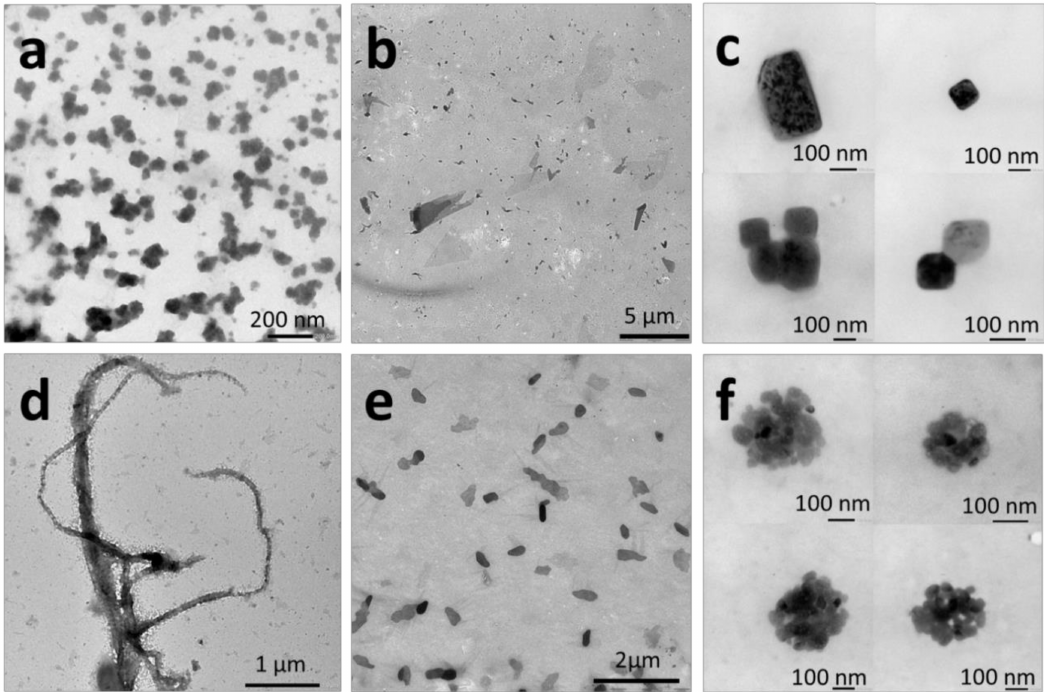
Figure 4. TEM images of self-assembled structures obtained by nanoprecipitation of 1 mg mL − 1 solutions of the P(VDF- co -HFP)- b -PEG- b -P(VDF- co -HFP) triblock copolymer in: ( a ) DMF, ( b ) acetone, ( c ) THF, employing ethanol as the selective solvent for PEG and ( d ) DMF, ( e ) acetone, ( f ) THF, employing water as the selective solvent for PEG. Final concentration of all samples = 0.09 mg mL − 1 . Solvent: selective-solvent final ratio =